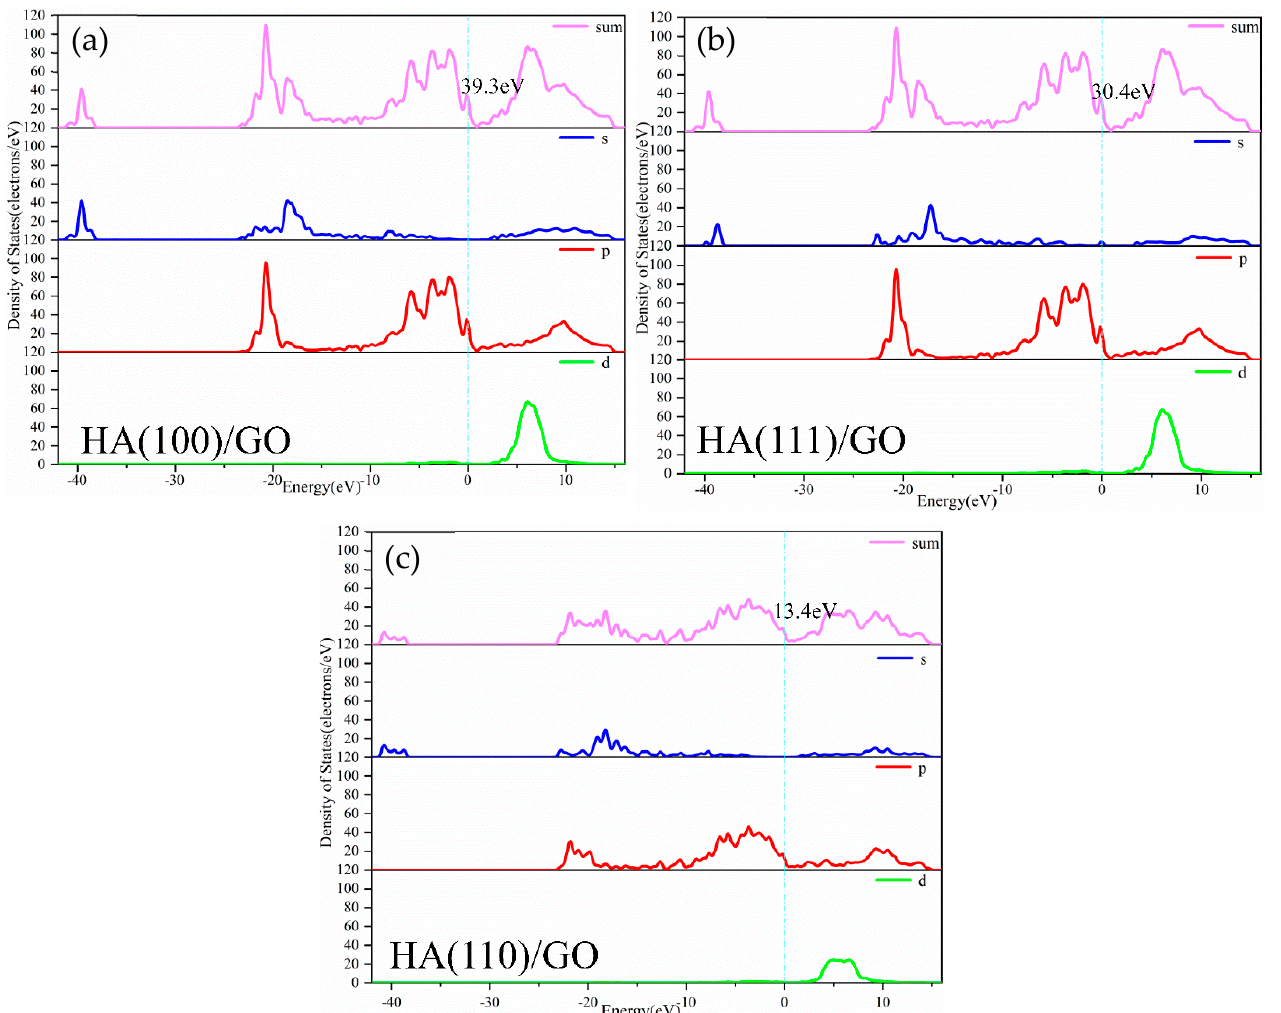
Figure 4. DOS diagrams of GO modified HA composite systems: ( a ) HA(100)/GO, ( b ) HA(110)/GO, ( c )HA(111)/GO.